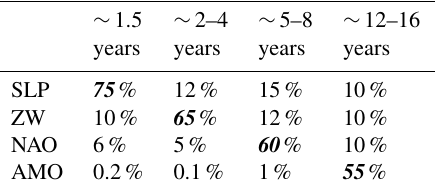
Table 2. The mean explained variance expressed as a percentage of total variance provided by the wavelet coherence between the extreme surges and the climate oscillations (SLP, ZW, NAO, AMO). ∼